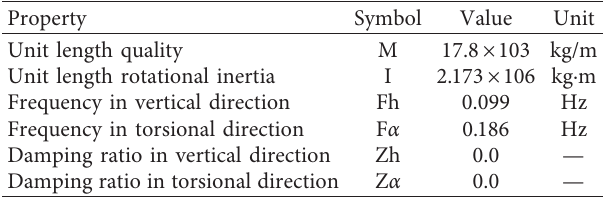
Table 2: Data of structural parameters of the bridge.